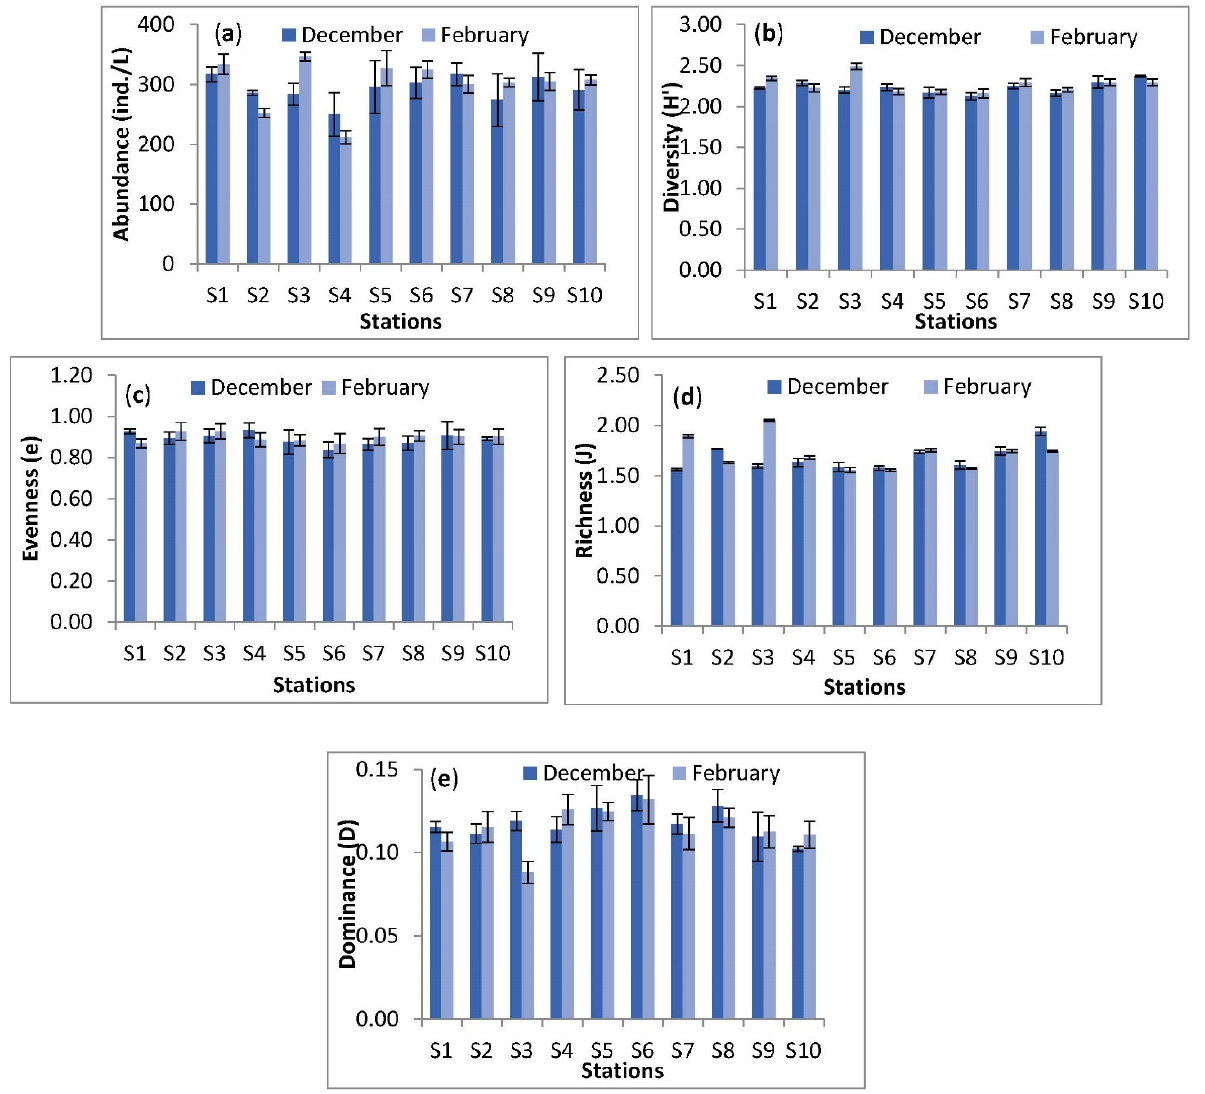
Figure 3. Spatial variation (mean ± SD) of ( a ) total zooplankton abundance, ( b ) Shannon–Wiener Diversity Index (H ′ ), ( c ) Evenness Index (e), ( d ) Margalef Species Richness Index (J), and ( e ) Dominance Index (D).